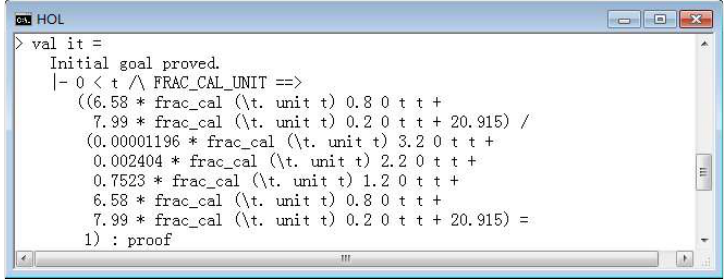
Figure 2. The result of verification.